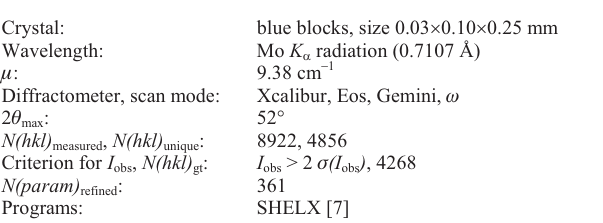
Table 1. Data collection and